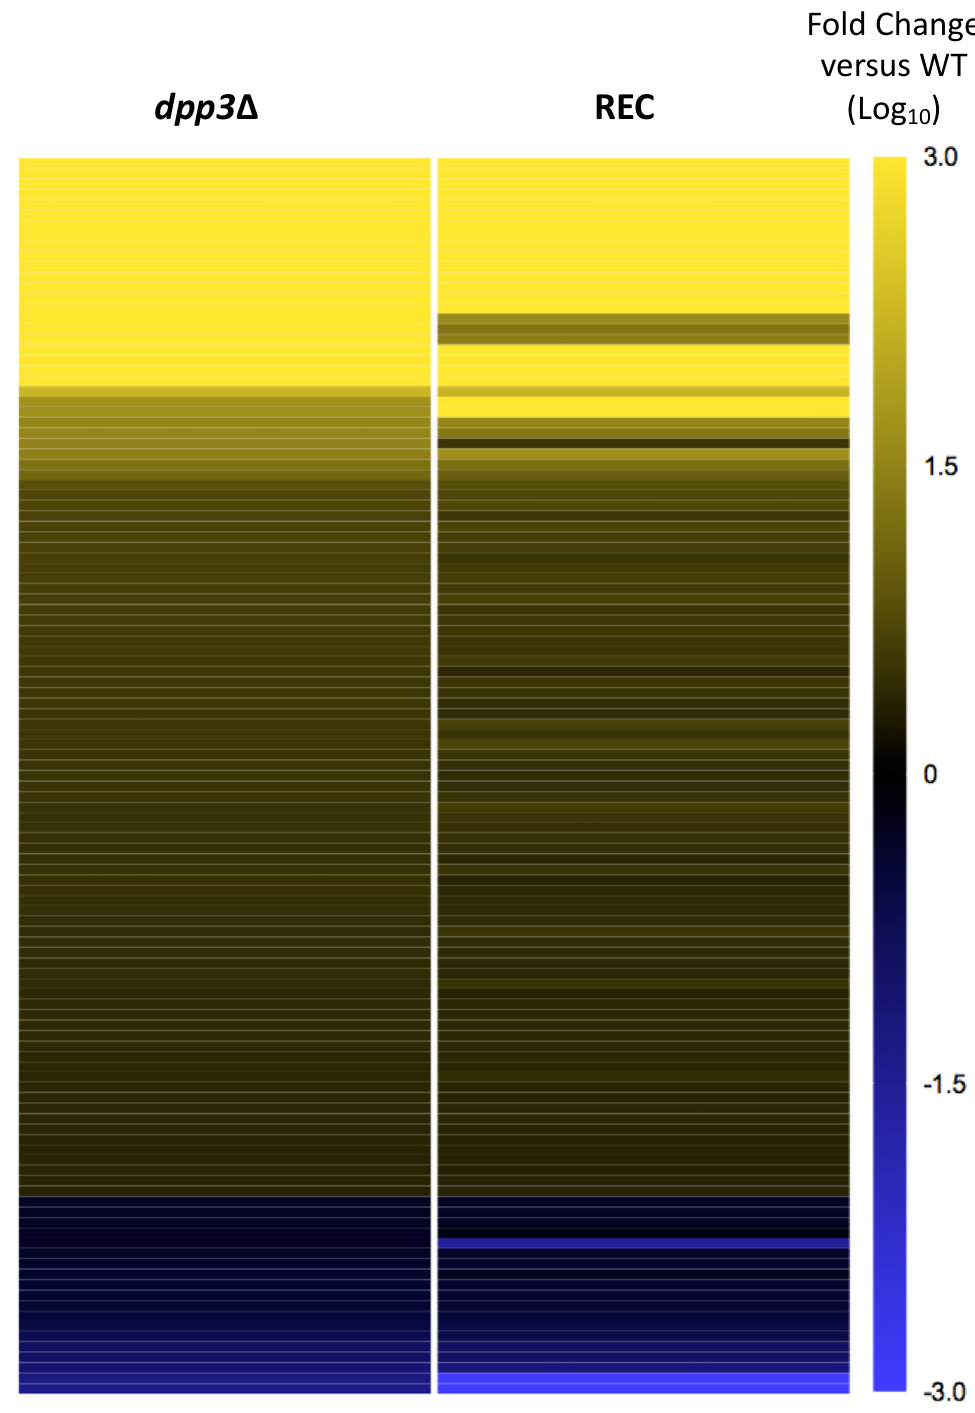
Figure 5. Heat map showing the REC strain the expression profile of the proteins deregulated at least 2-fold ( p value < 0.05) in the dpp3 Δ relative to the WT. Proteins that were not quantified in at least two biological replicates out of the three in both the dpp3 Δ and the REC strains were taken out of the analysis. The heat map was generated in Prism8. The fold change (Log 10 ) relative to the WT is color coded as indicated in the side panel. The proteins deregulated in the dpp3 Δ mutant were still deregulated in the REC strain despite a wild-type copy of DPP3 being reintegrated, likely reflecting changes attributable to med15 Δ mutation.